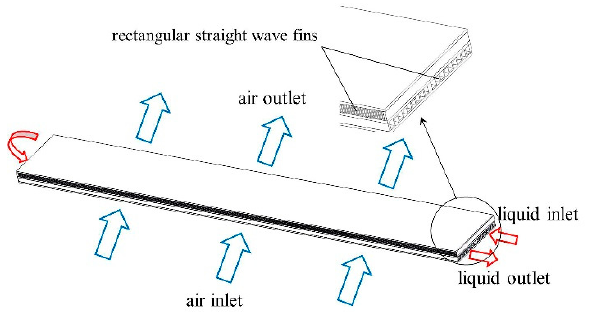
Figure 2. Structure of the equivalent plate-and-fin heat exchanger (PFHX).